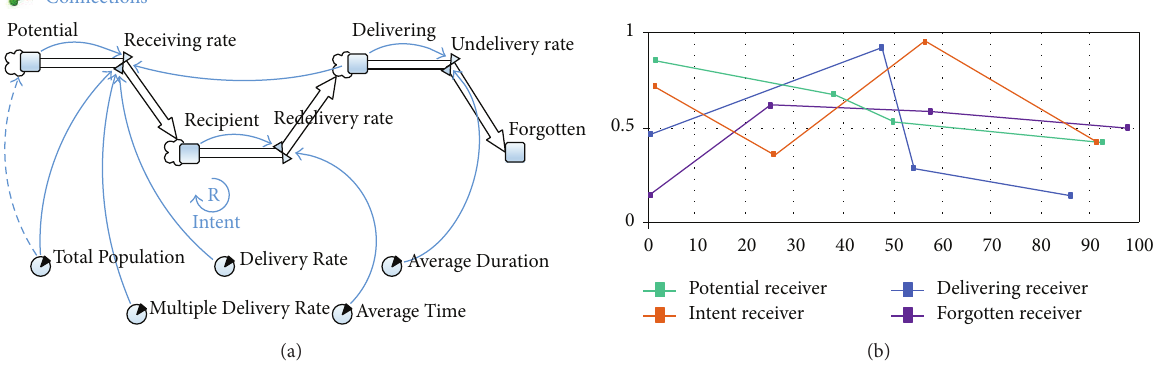
Figure 1: The information simulation model of collaborative